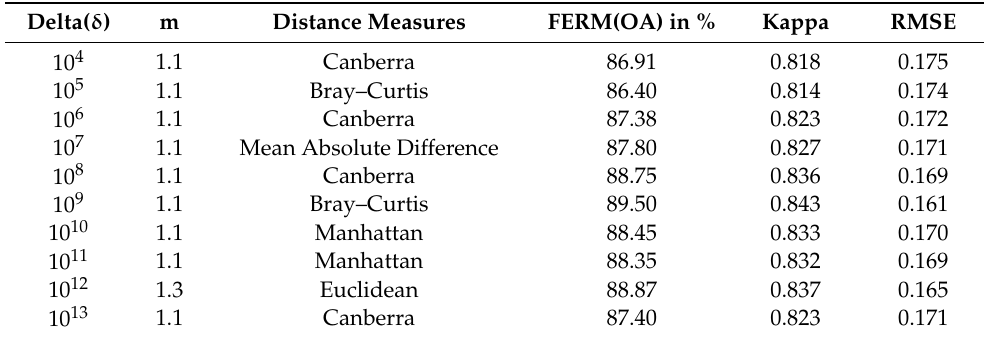
Table 3. Kappa and RMSE determined for the highest overall accuracy of the NLICM classifier by applying different parameters for site 1 (Haridwar).